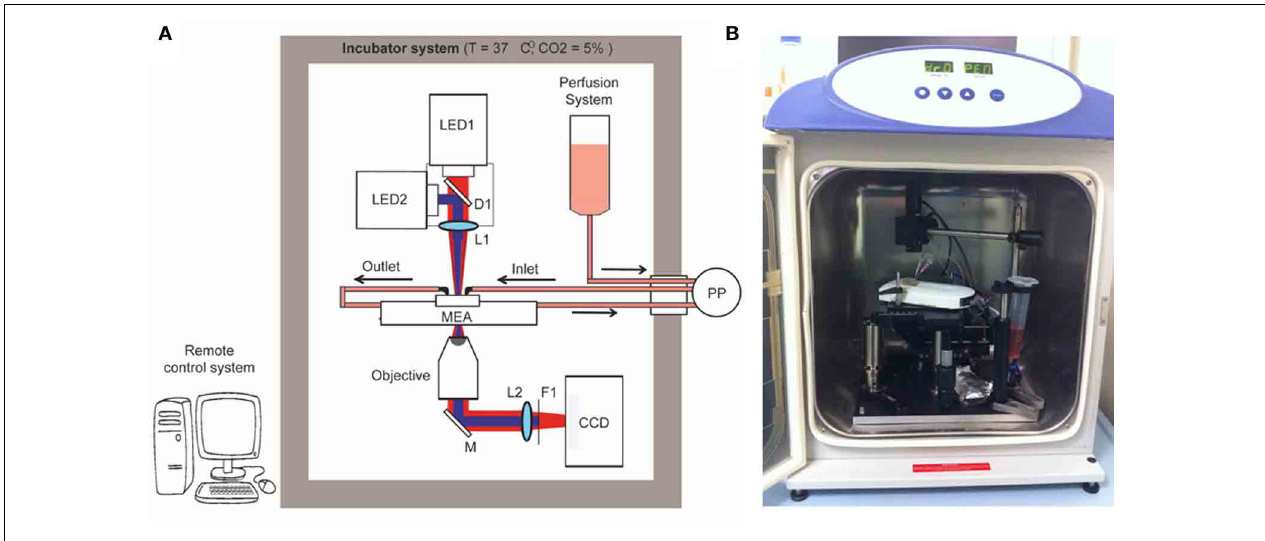
FIGURE 1 | Optical setup. Schematic overview (A) and picture (B) of the OM-CSR setup combining optical recordings, optical stimulation and MEA recordings embedded in an incubator that maintains a